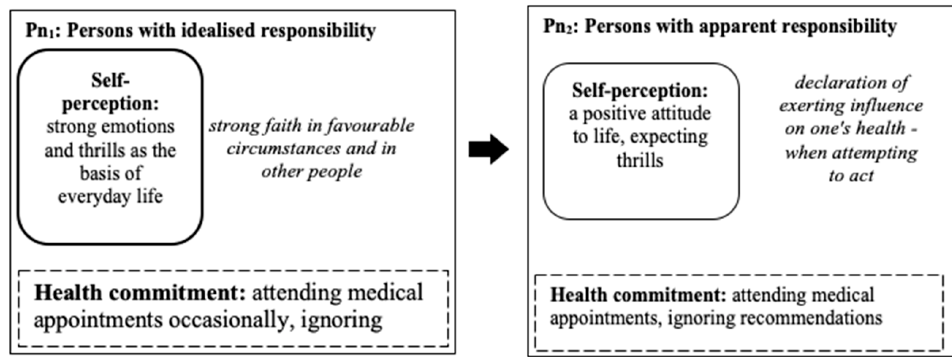
Figure 7. The sub-models responsibility for one’s health from idealised responsibility to apparent responsibility among the mixed group.